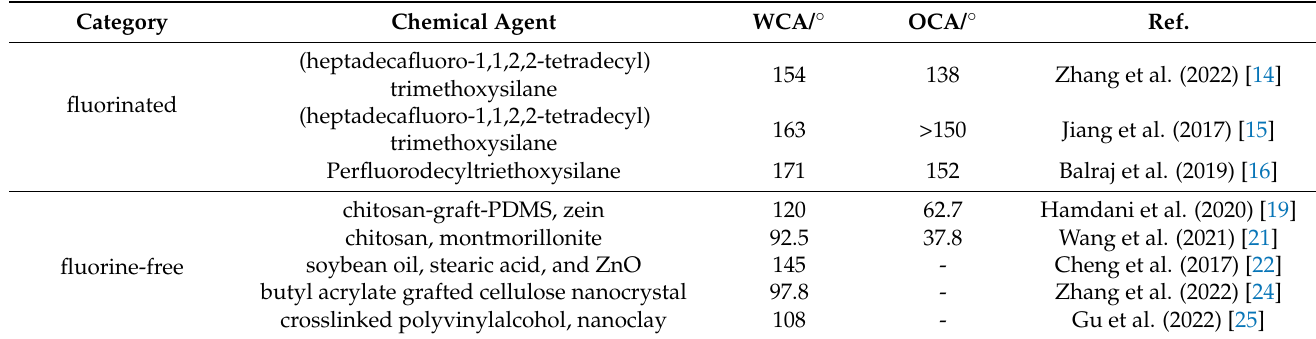
Table 1. Summary of previously related fluorinated and fluorine-free amphiphobic